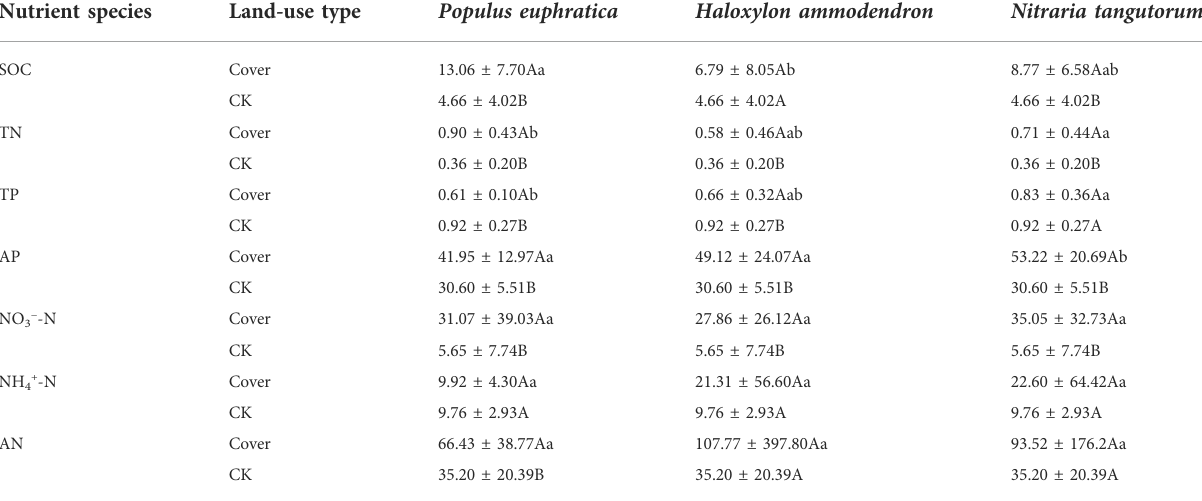
TABLE 2 Difference analysis of soil nutrients under three woody plant canopies. Nutrient